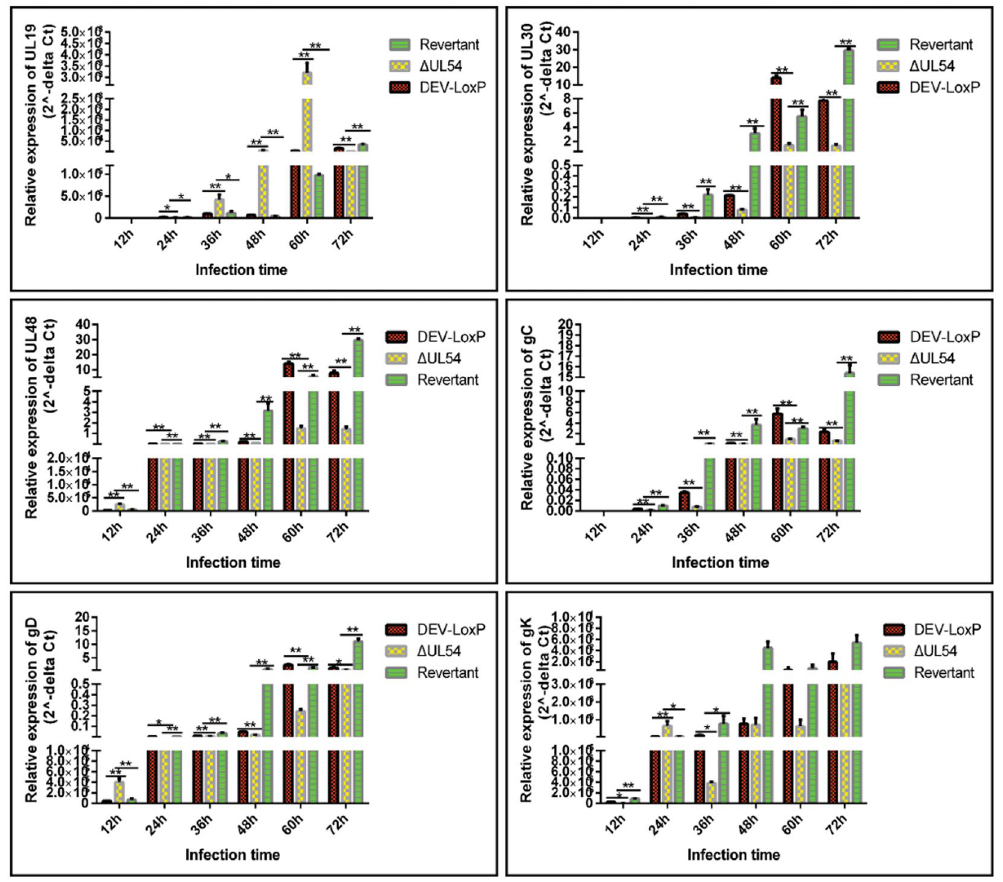
Figure 4. Effects of DEV UL54 on viral mRNA expression. DEFs were infected with DEV-LoxP, DEV- Δ UL54 or DEV- Δ UL54 (Revertant) at 200 TCID 50 , and RT-PCR was performed to assess the relative expression levels of UL19, UL30, UL48, gC, gD and gK at different time points. * p < 0.05; ** p <